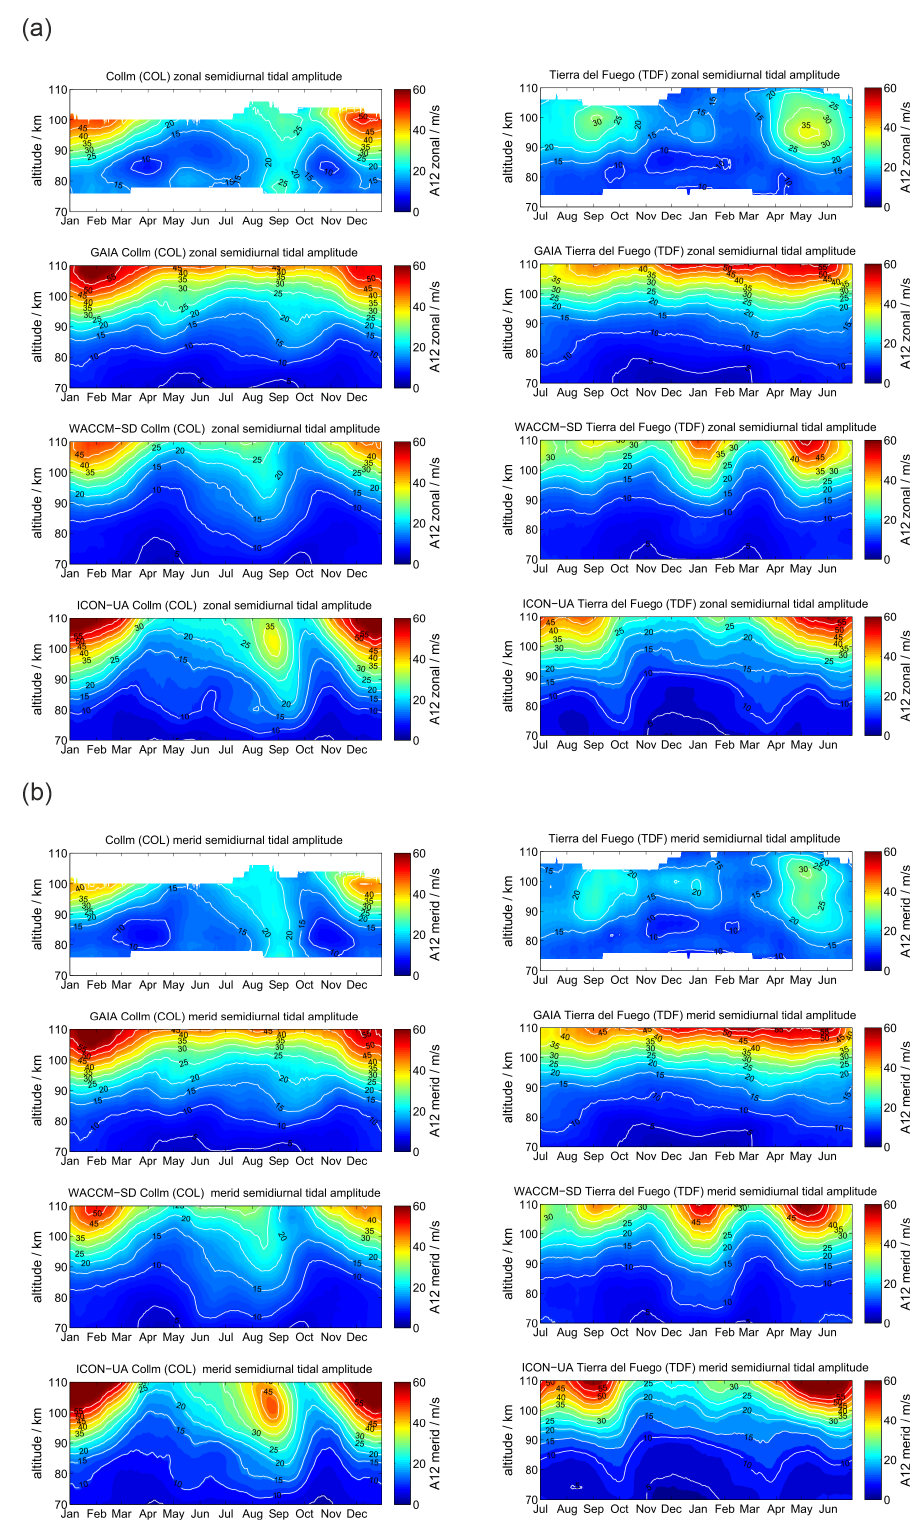
Figure 13. The same as Fig. 2, but for the semidiurnal tidal amplitudes above COL and TDF.